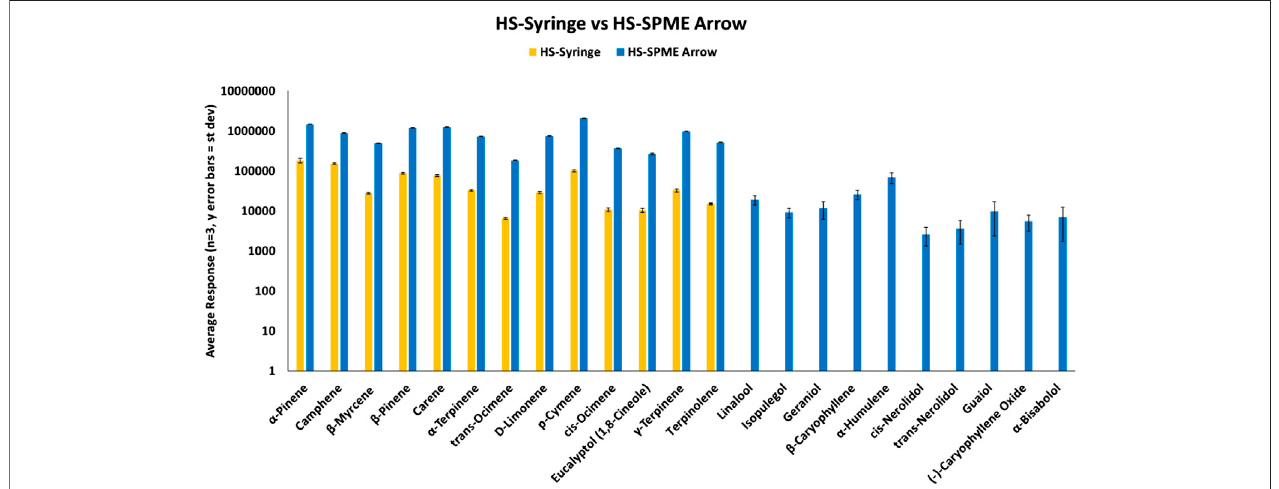
FIGURE 1 | HS-SPME Arrow vs DI-SPME Arrow for